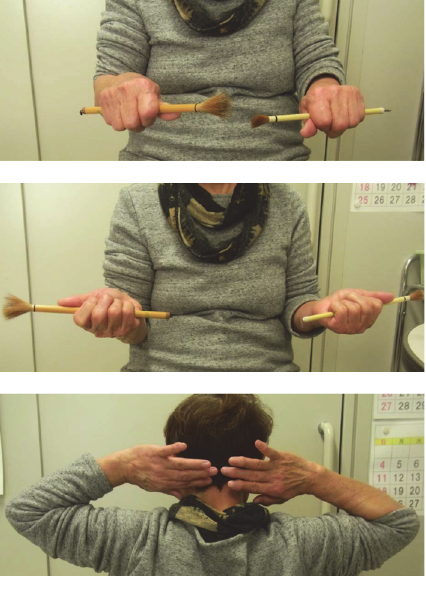
Figure 6: After 8 weeks, the elbow range of motion was from 0 ∘ to 125 ∘ , supination to 90 ∘ , and pronation to 90 ∘ .